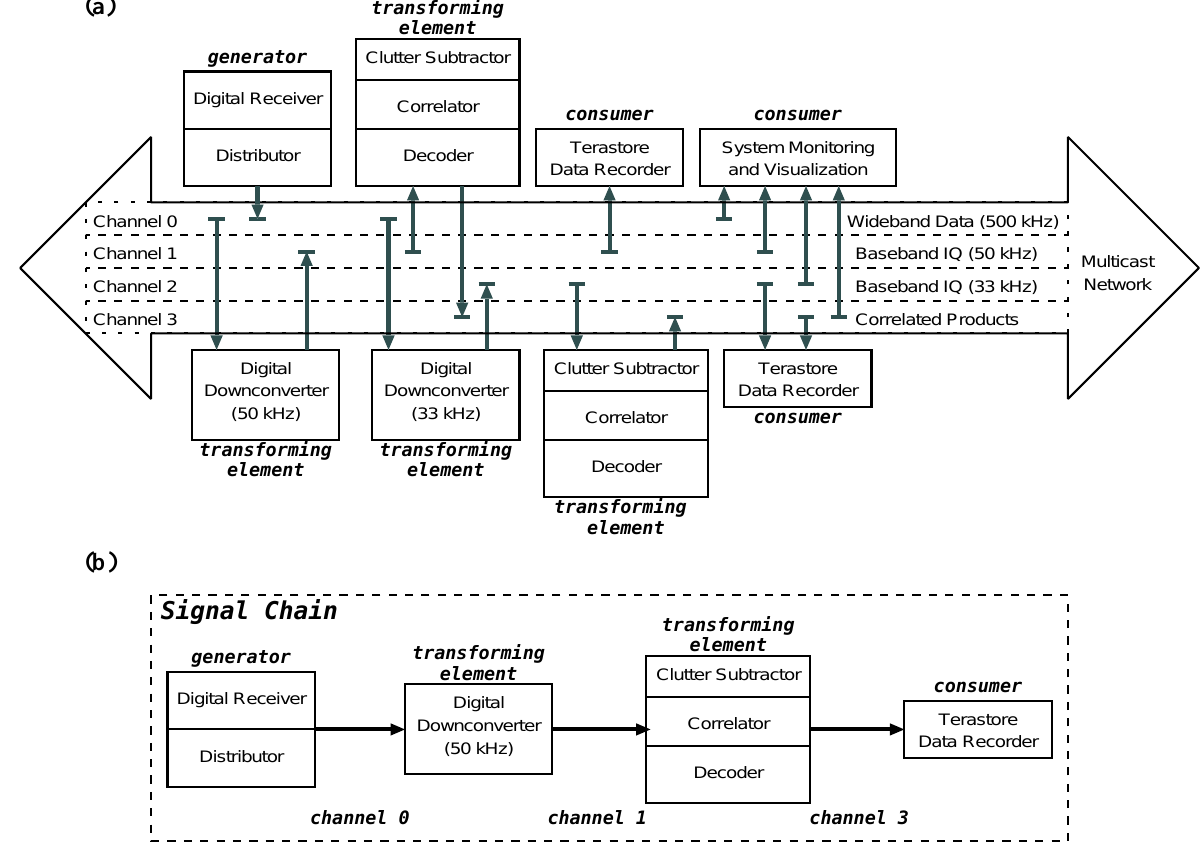
Fig. 2. Multicast channels provide a means of organizing information in a Software Radar system. By allowing multiple software agents to simultaneously access data in the system a high degree of parallelism is possible. ( a ) Data related channels and processing elements are shown at the network level. ( b ) A typical signal chain (cf. Sect. 3.1) used for producing correlated and decoded output as part of coded pulse processing. Multiple signal chains can exist using the same network channels and input data streams to provide different types of signal